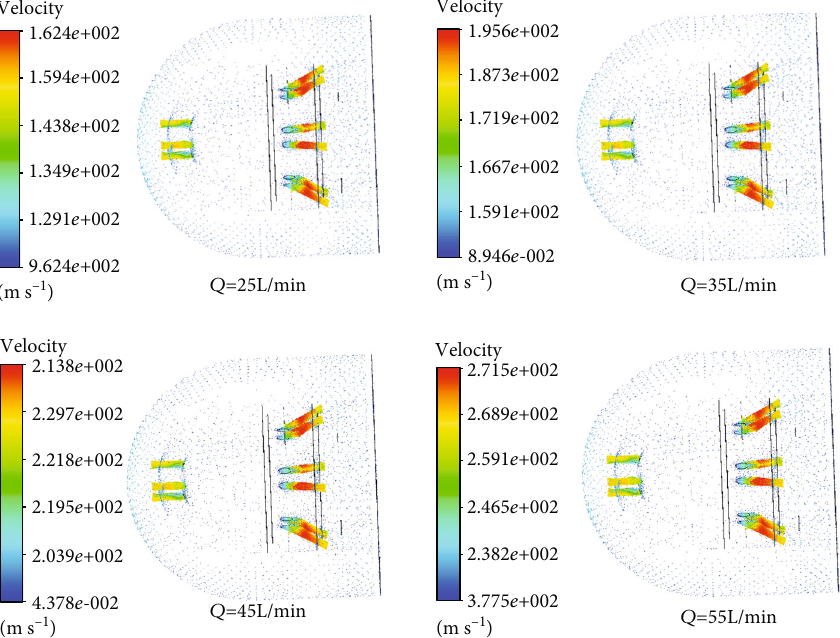
Figure 6: The jet velocity distributions of backward ori fi ce under di ff erent inlet